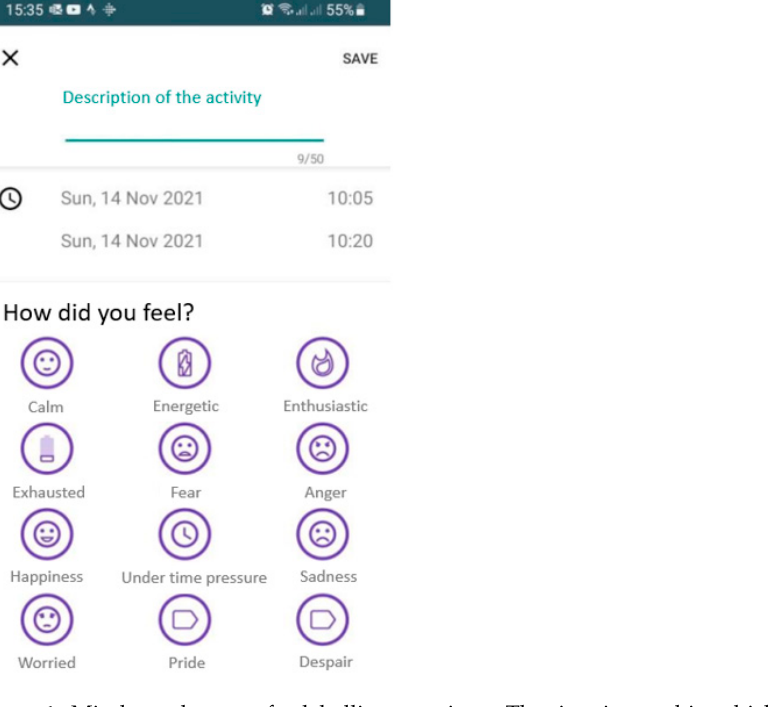
Figure 1. Mindstretch menu for labelling emotions. The time interval in which the emotion was experienced can be adjusted. Below, the experienced emotion is designated.